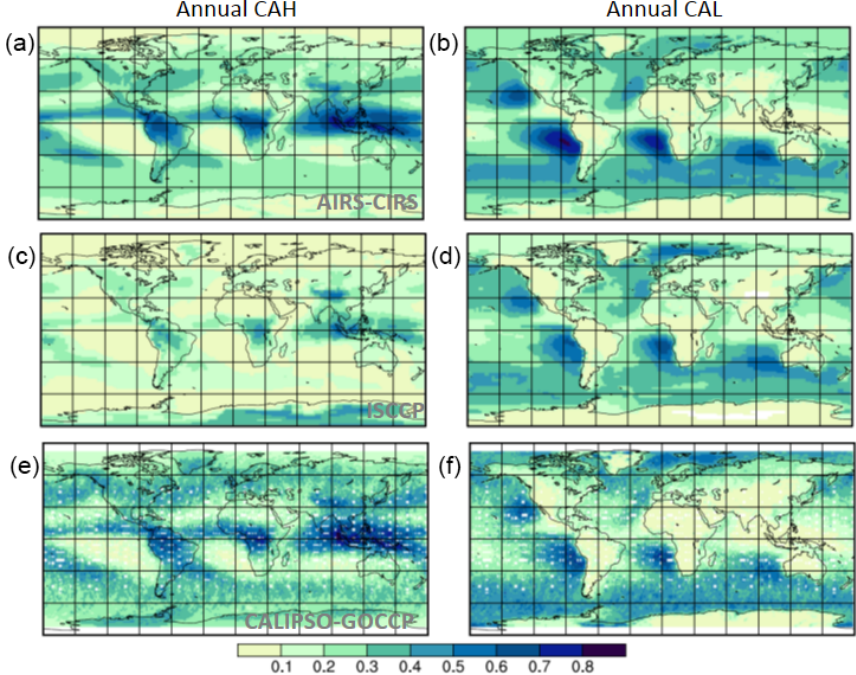
Figure 9. (a, b) : Geographical maps of annual CAH (a, c, e) and CAL (b, d, f) , from AIRS-CIRS (2003–2015, top), ISCCP (2003–2007, c, d ) and CALIPSO-GOCCP (2007–2008, e, f ), the latter two from the GEWEX Cloud Assessment database. White areas correspond to no data. Table 3. Averages of relative amount (in%) of opaque ( ε cld >0.95), cirrus (0.95> ε cld >0.5) and thin cirrus (0.5> ε cld >0.1) from AIRS- CIRS (2003–2015), using AIRS-NASA and ERA-Interim ancillary data; and IASI-CIRS (2008–2015), using ERA-Interim ancillary